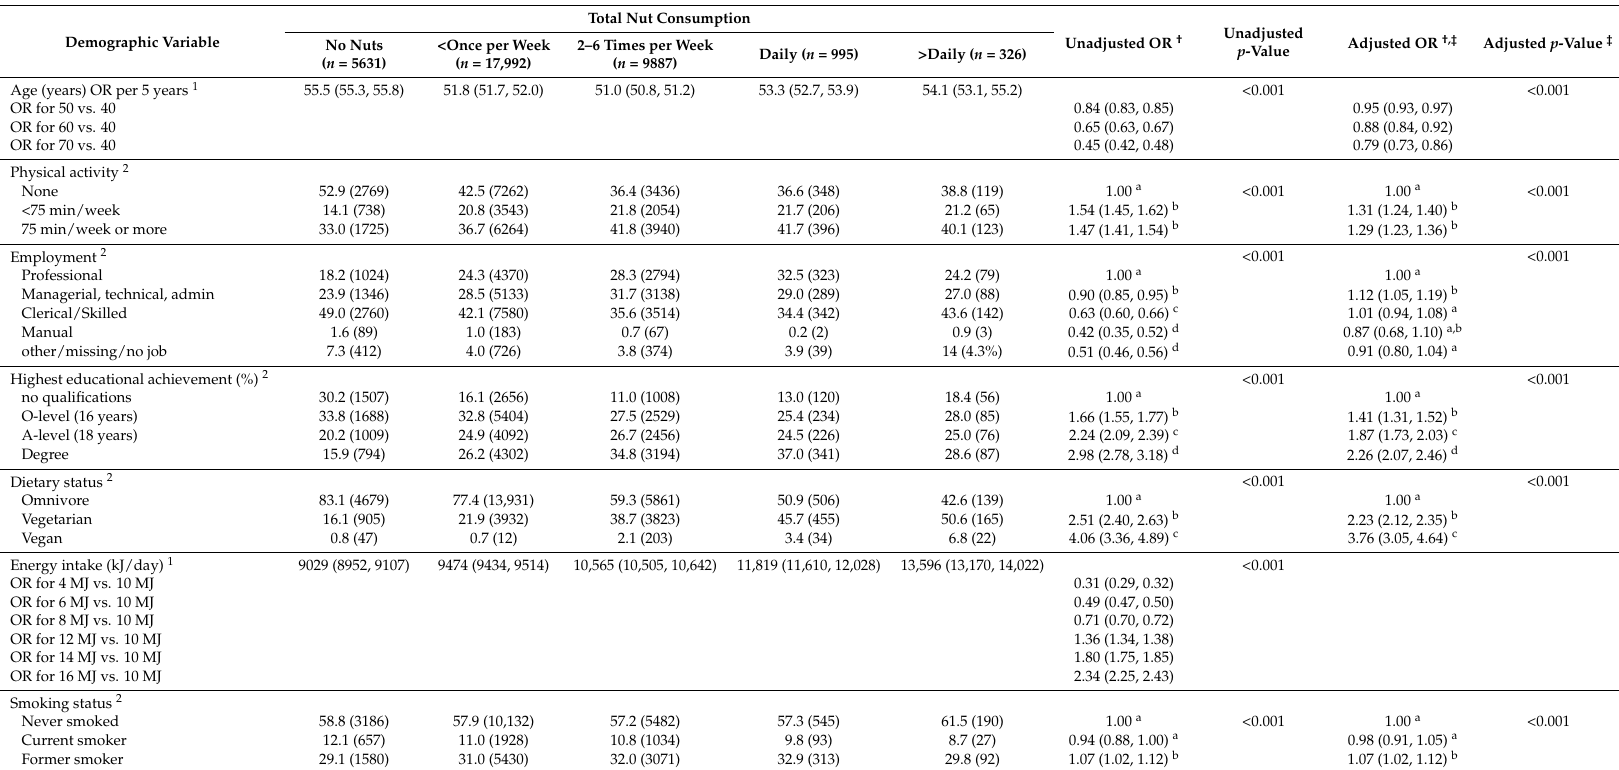
Table 2. Predictors of nut consumption